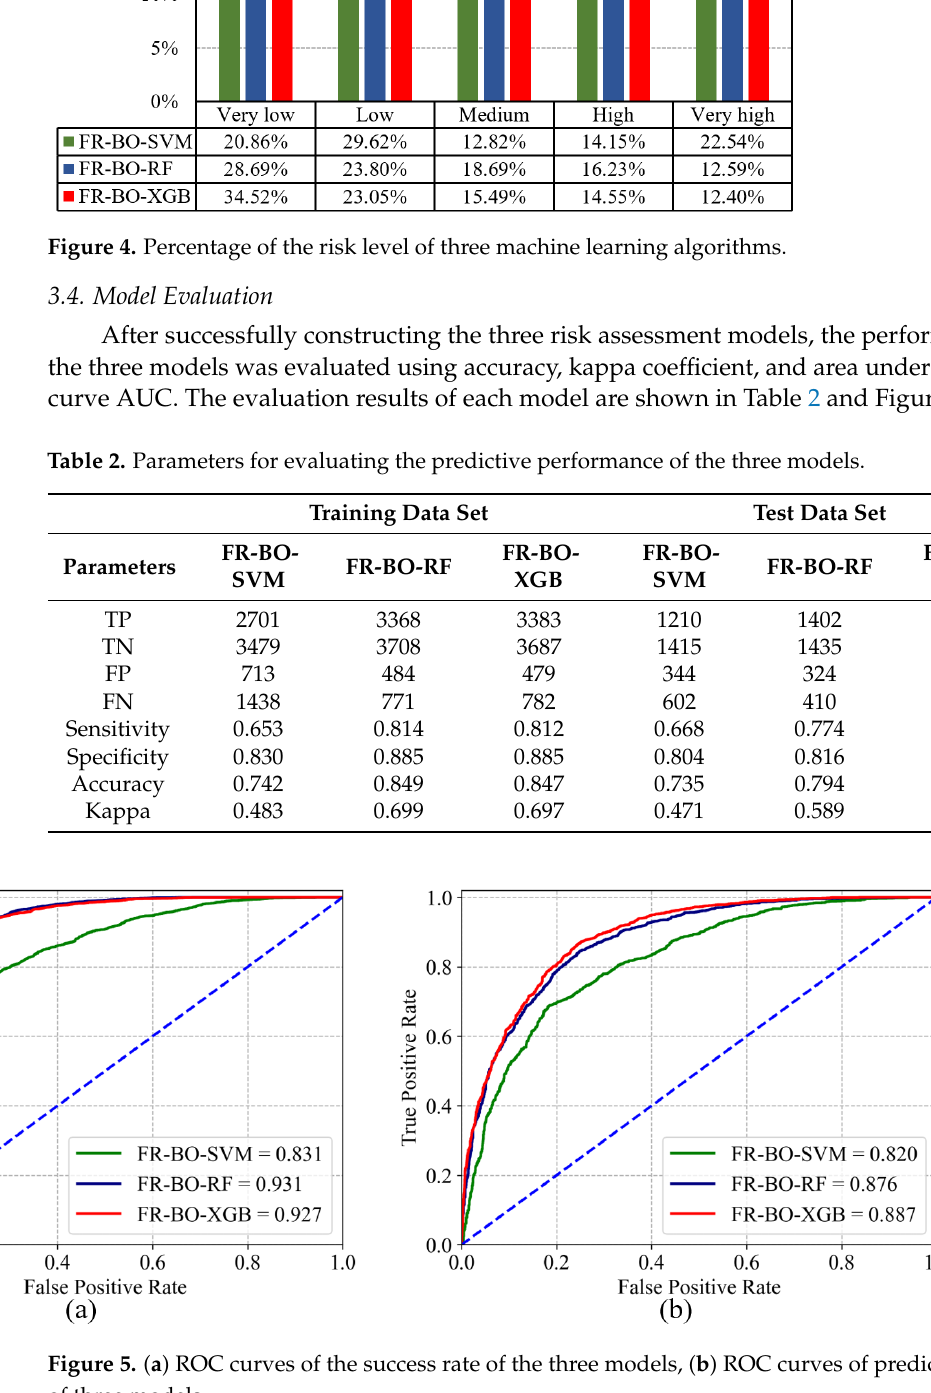
Figure 5. ( a ) ROC curves of the success rate of the three models, ( b ) ROC curves of prediction rates of three